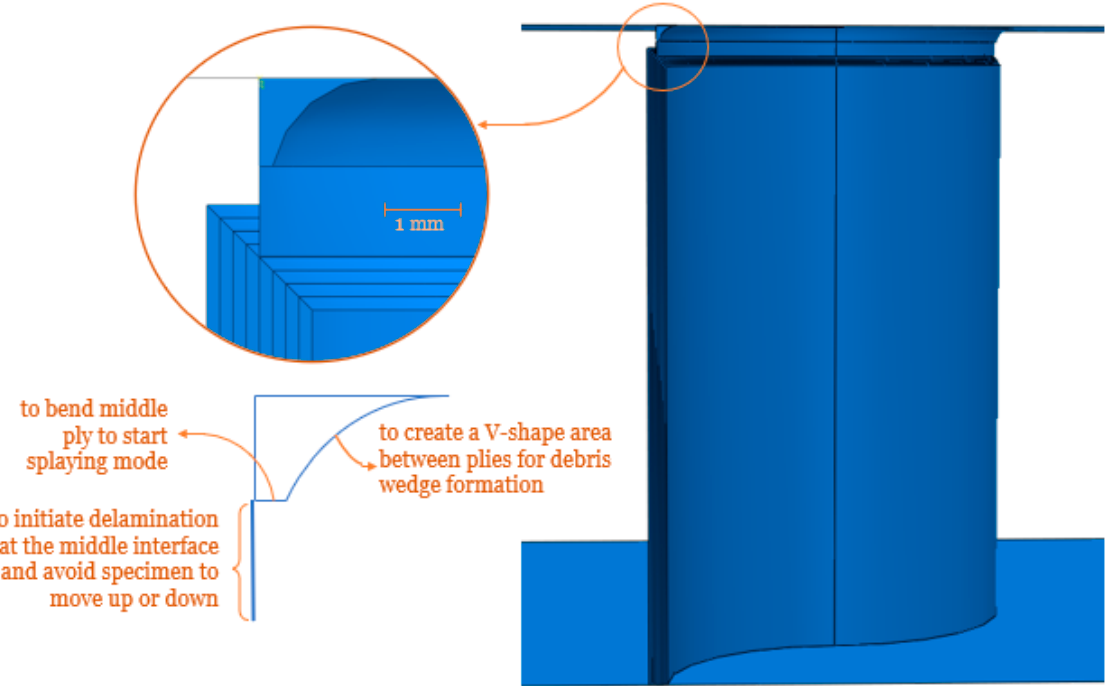
Figure 6. The finalized version of the artificial plug-initiator design with the position in assembly.